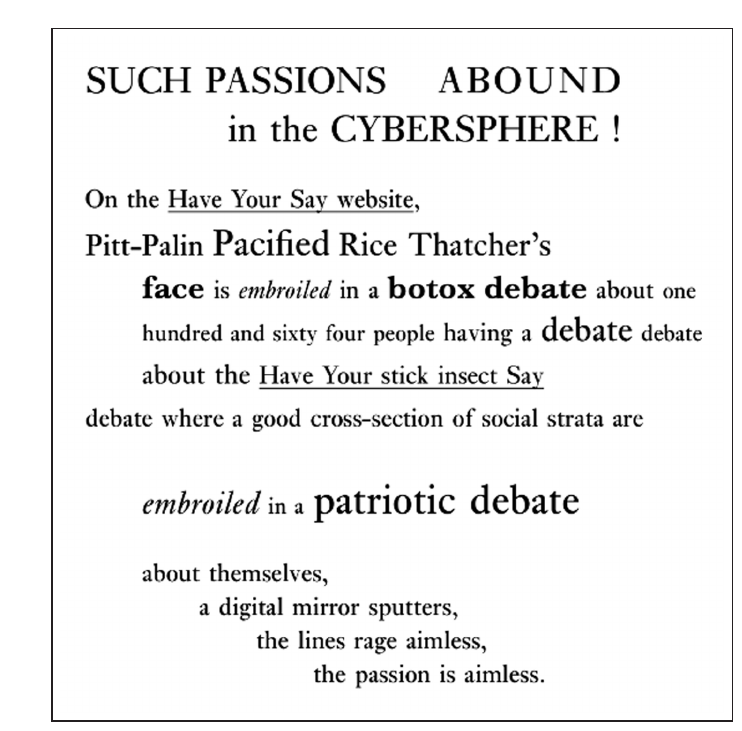
Figure 1: Marianne Morris, “Who Not to Speak To” (2013).